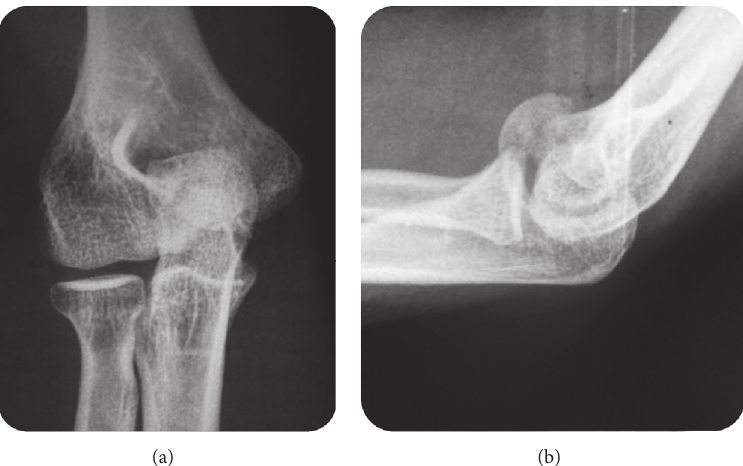
Figure 1: (a) Anteroposterior and (b) lateral radiographs showing an intra-articular half-moon-shaped fragment lying proximal and anterior to the distal humerus simulating a capitellar fracture with irregularities over the trochlear-olecranon articulation surface.